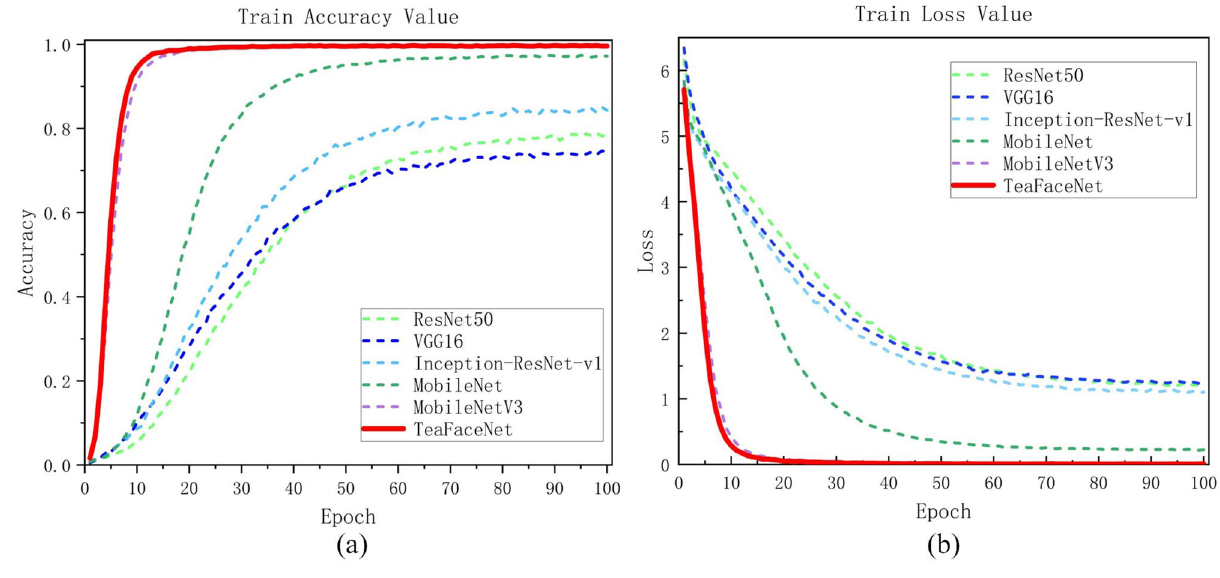
Figure 13. Loss and accuracy of mixed dataset.